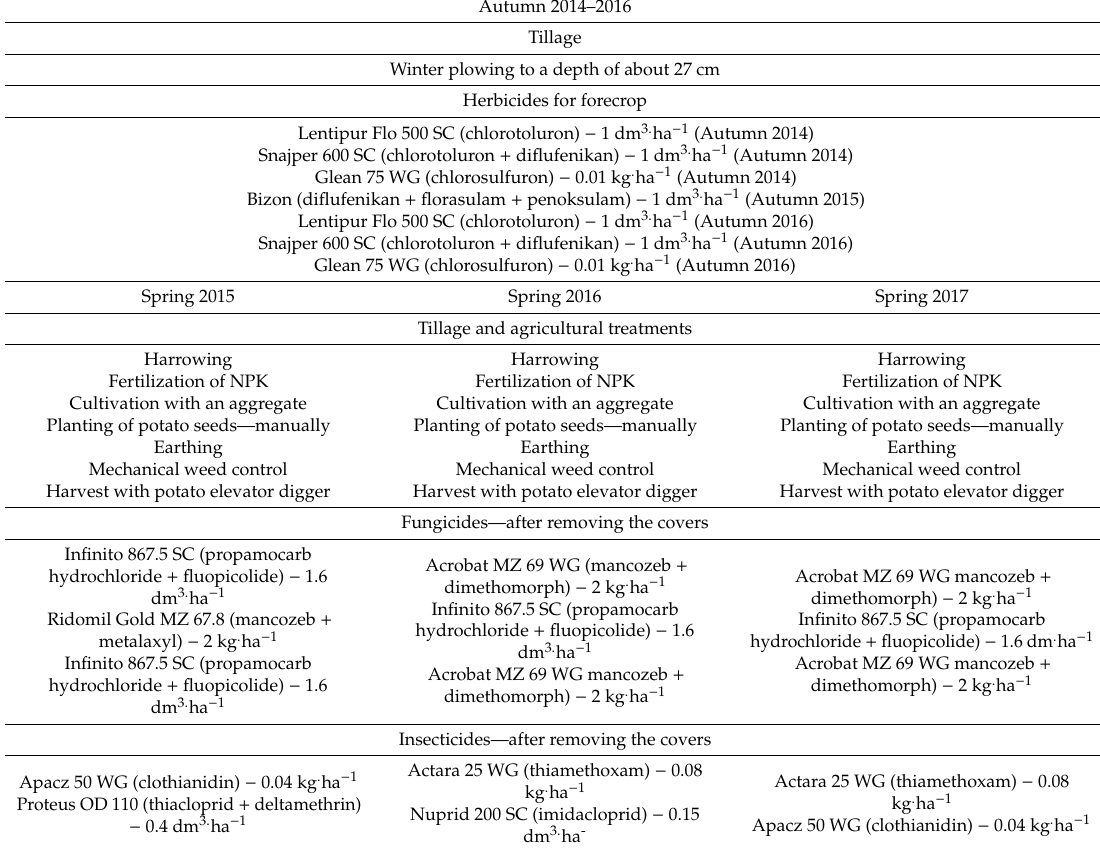
Table 1. The agricultural treatments and plant protection products used in the experiment in the years